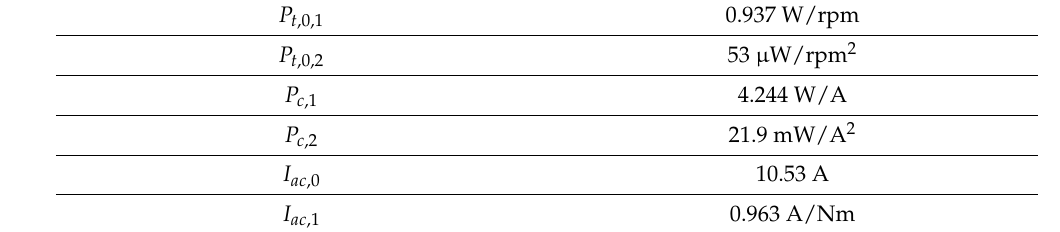
Table 2. Efficiency function parameters.